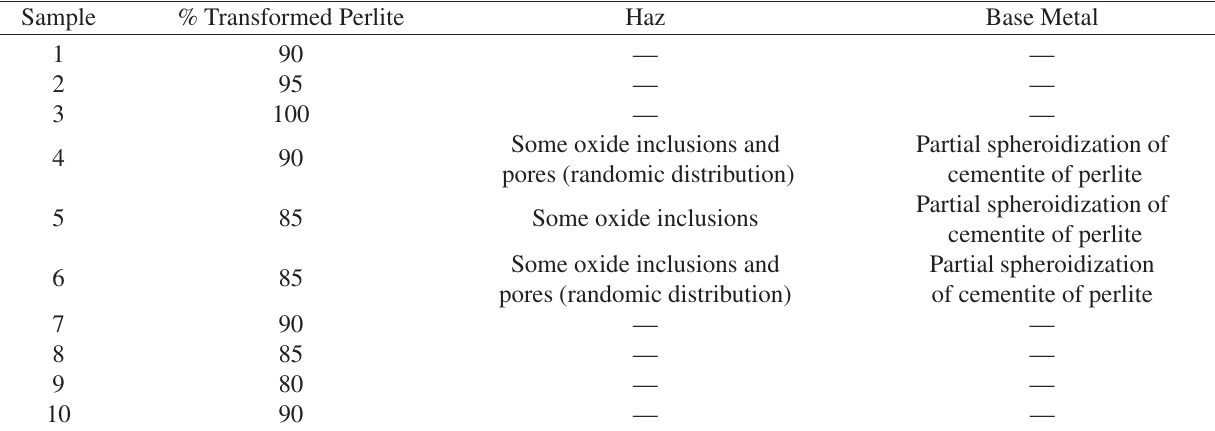
Table 3. Percentages of transformed perlite for each